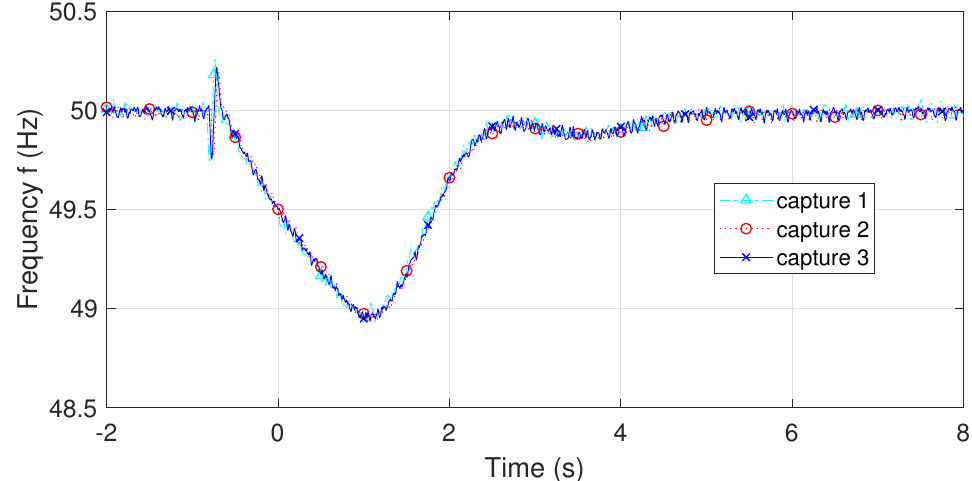
Figure 11. Repeatability of the C-HIL simulation: Considering that the C-Hil simulation, includes sampling and delays due to communication between the two devices, we wanted to prove how the repeatability is guaranteed, so we repeated the simulation under the same conditions.